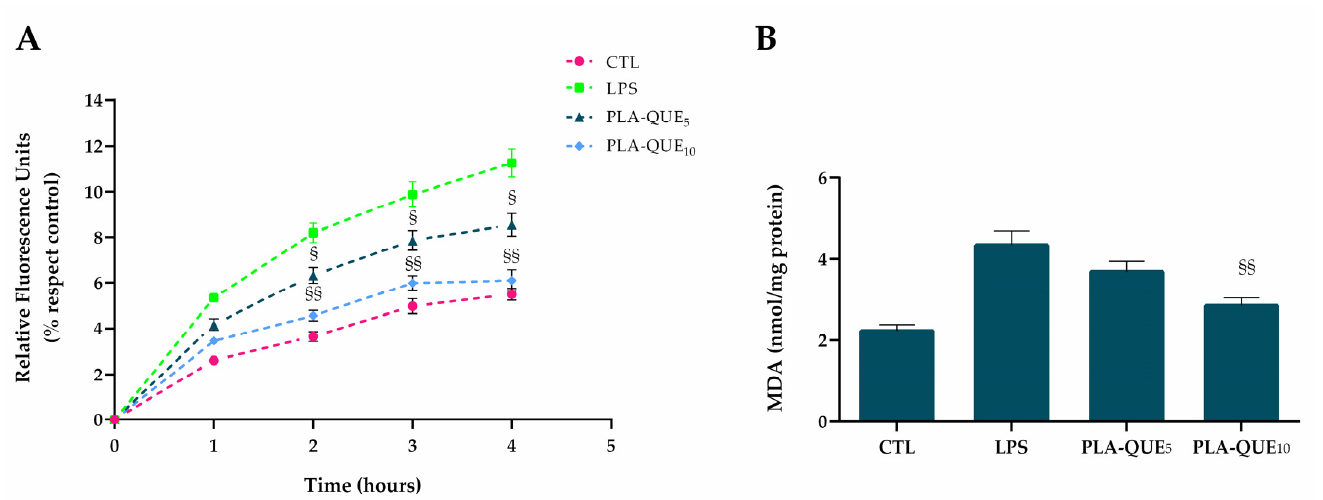
Figure 5. QUE reduced the production of reactive oxygen species (ROS) and lipid peroxidation in LPS-stimulated human gingival fibroblasts (HGF). ( A ) ROS production was determined by the DCF fluorescence intensity using a microplate reader. ( B ) Malondialdehyde was used as a marker of lipid peroxidation. Treatment with LPS of Porphyromonas gingivalis (1 µg/mL) is a positive control. Each graph represents three independent experiments, and the data are expressed as mean ± S.D. Statistically significant variations: § p < 0.05 and §§ p < 0.01 versus LPS.